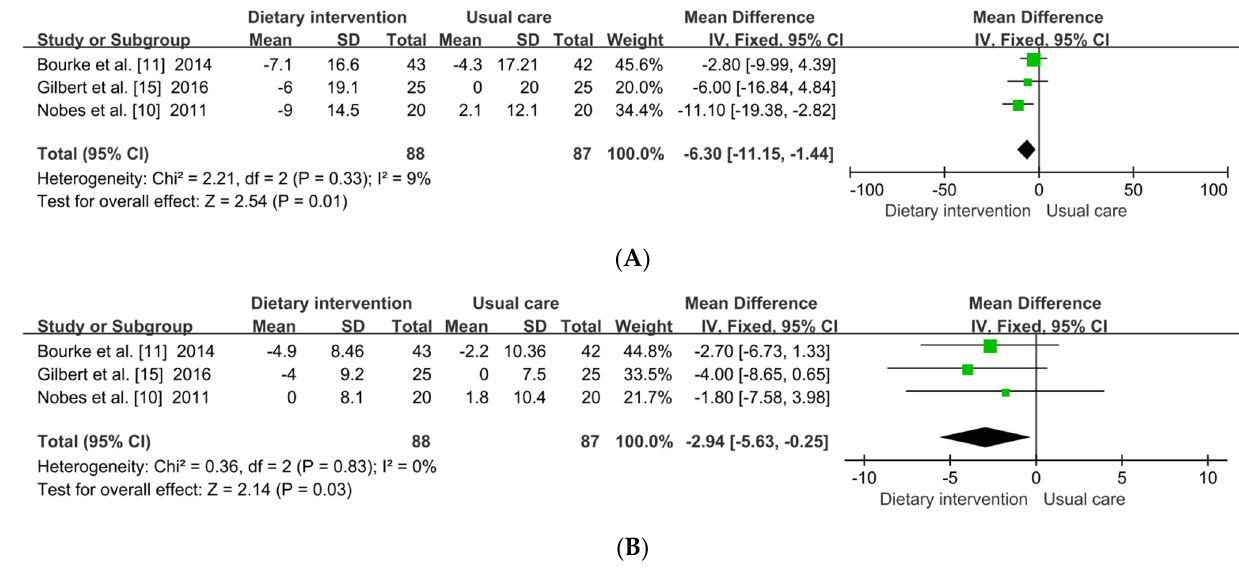
Figure 5. Forest plot of effect of healthy DP on BP. DP, dietary pattern; SBP, systolic blood pressure; DBP, diastolic blood pressure; BP, blood pressure; the diamond, effect size and 95%CIs; green color, weight. ( A ) SBP and ( B ) DBP [10,11,15].